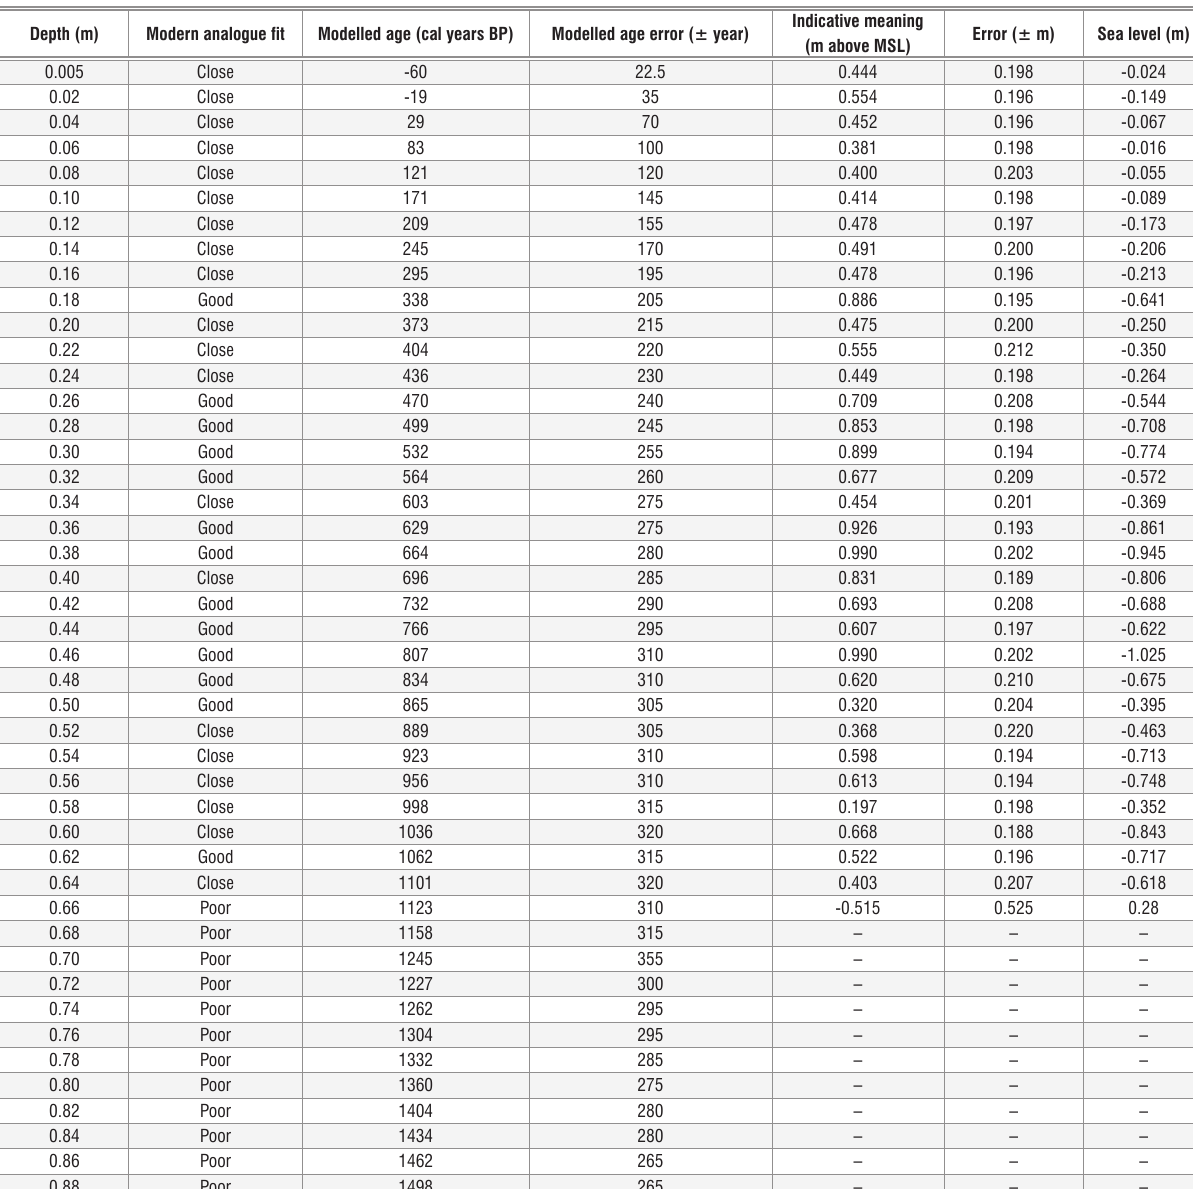
Table 4: Results from the transfer function applied to the fossil data Depth